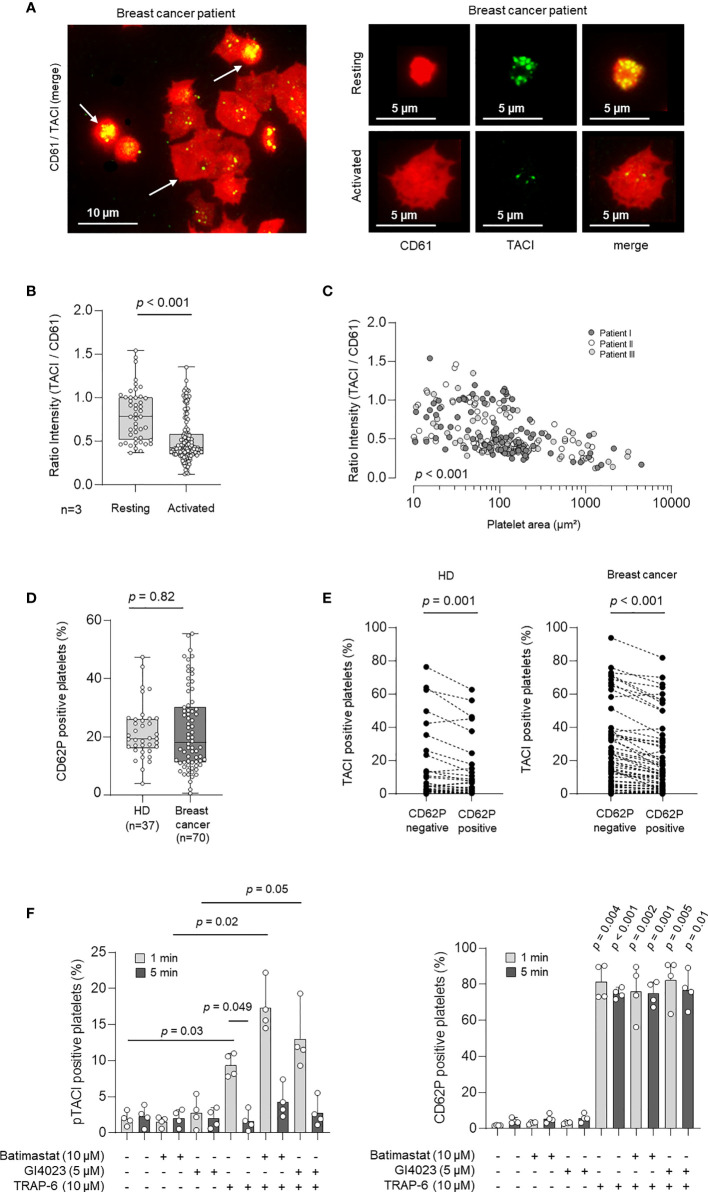
Expression and regulation of pTACI upon platelet activation. (A) Immunofluorescence analysis of pTACI (labeled in green) and CD61 (labeled in red) expression in activated and resting platelets from a breast cancer patient. (B) Ratio intensity of TACI/CD61 in resting and activated platelets obtained from 3 breast cancer patients (p < 0.001). Dots indicate a single quantified platelet. (C) Correlation of the ratio intensity of TACI/CD61 and the platelet area (µm²), (p < 0.001). Each dot indicates a single quantified platelet area (Data from patient I are labeled in dark gray, data from patient II in white, data from patient III in light gray). (D) Expression of the platelet activation marker CD62P (P-selectin) in platelets from HD and breast cancer patients ex vivo (p = 0.082). (B, D) Within each box, horizontal lines denote 25th percentile, median, 75th percentile (bottom to top) of each group’s distribution values. Whiskers indicate maximal and minimal expression levels. (E) pTACI level in HD (left panel) and breast cancer patients (right panel) with regard to CD62P expression is shown. (F) Expression of pTACI (left panel) and the platelet activation marker CD62P (P-selectin, right panel) in platelets from HD in the presence or absence of TRAP-6, or the indicated metalloproteinase inhibitor (GI254023, ADAM 10; Batimastat, broad spectrum). Platelets were activated for 1 min or 5 min as previously described (20).